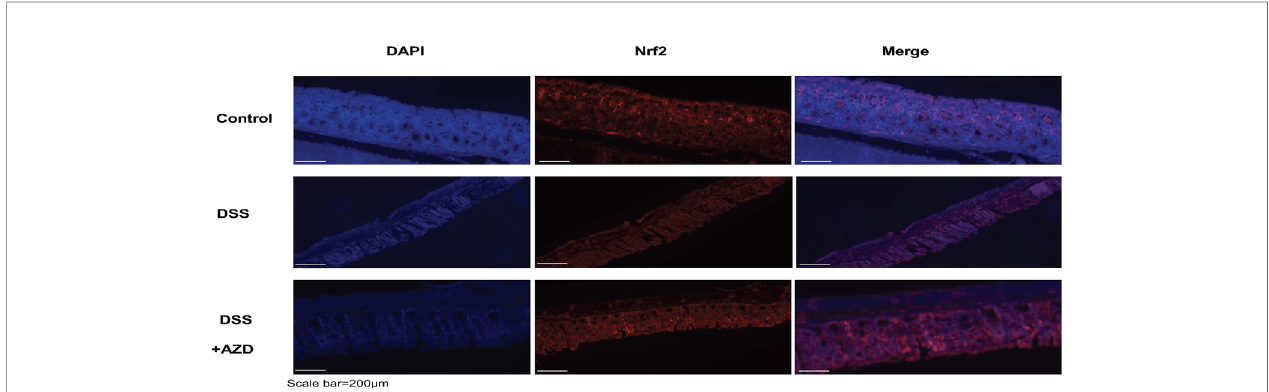
FIGURE 8 | Representative Nrf2 immuno fl uorescence images of colon sections challenged with DSS for 9 days. Mice were randomly divided into three treatment arms over 9 days i) vehicle group (n = 5) given normal drinking water and peanut butter without drug; ii) dextran sodium sulfate (DSS) group (n = 5) given 2% w/v DSS in drinking water and peanut butter without drug; iii) DSS+AZD3241 (n = 5) given 2% w/v DSS in drinking water and AZD3241 @ 30 mg/kg in peanut butter. Colons were resected after 9 days of treatment, embedded in paraf fi n and sectioned for immuno fl uorescence studies as described in the methodology section. Representative images were taken from at least three fi elds of view from each colon at 20x magni fi cation on a multi fi lter fl uorescent microscope (ZEISS AXIOscope; Talavera Rd, Sydney, Australia). AZD3241 is abbreviated to AZD in this fi